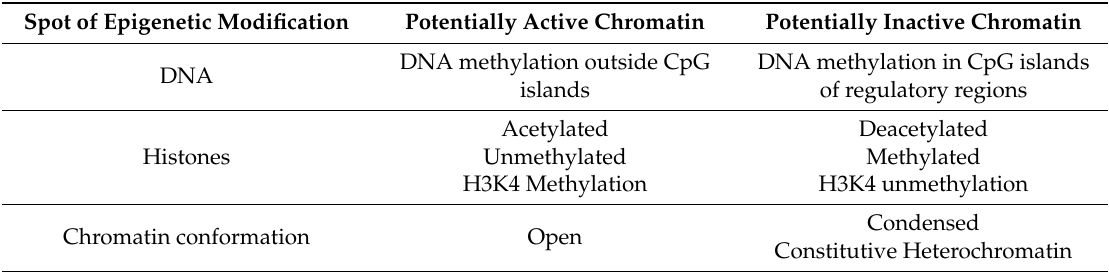
Table 1. Relationship between the epigenetic modifications and the state of the